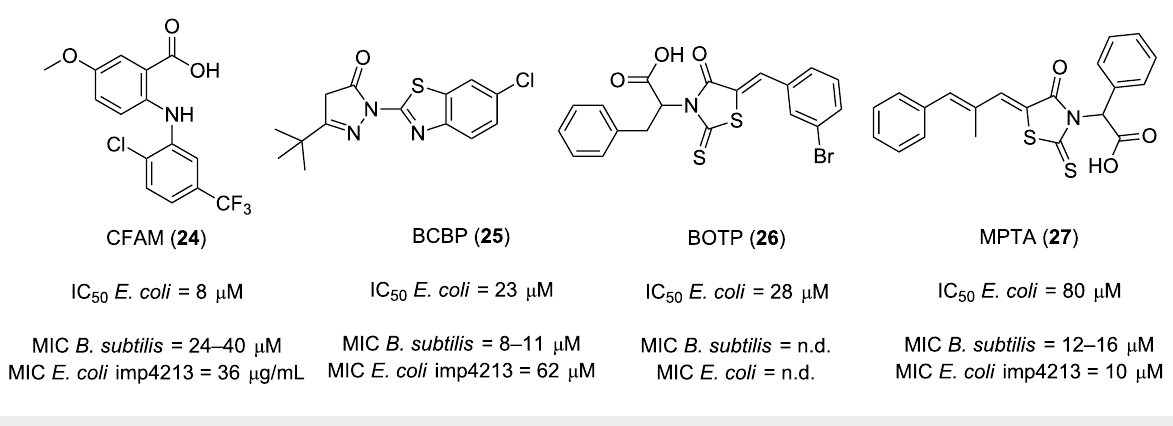
more than 72,000 compounds from Life Chemicals Inc.